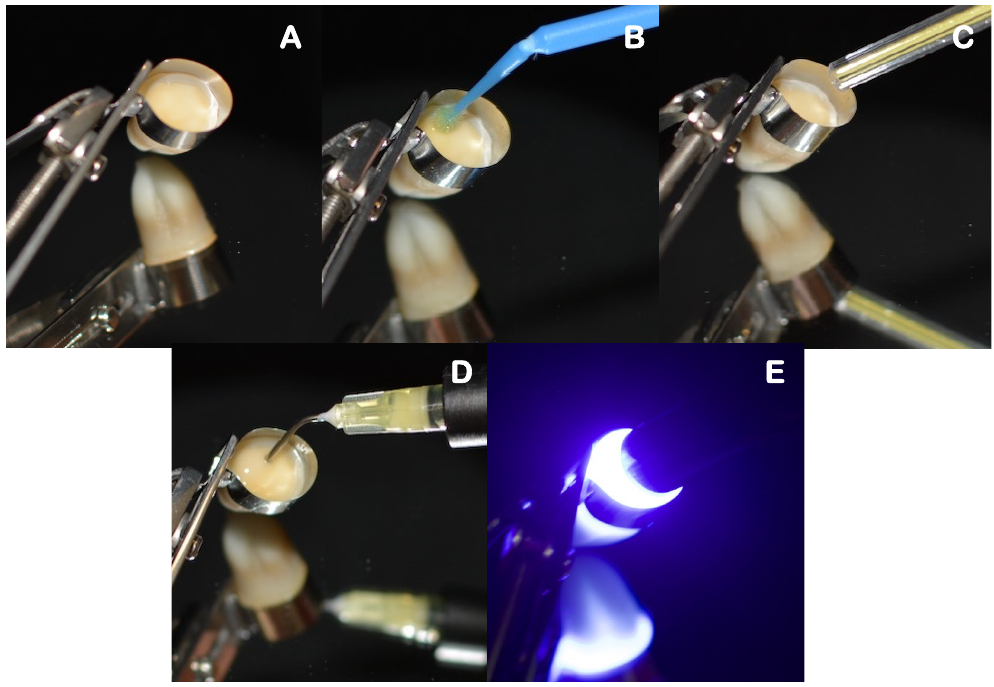
Figure 4. Restorative procedure of the primer co-curing group, where: ( A ) is the application of the restorative matrix band, ( B ) application of the primer, ( C ) drying step, ( D ) application of the flowable self-adhesive composite, and ( E ) light curing of each increment.